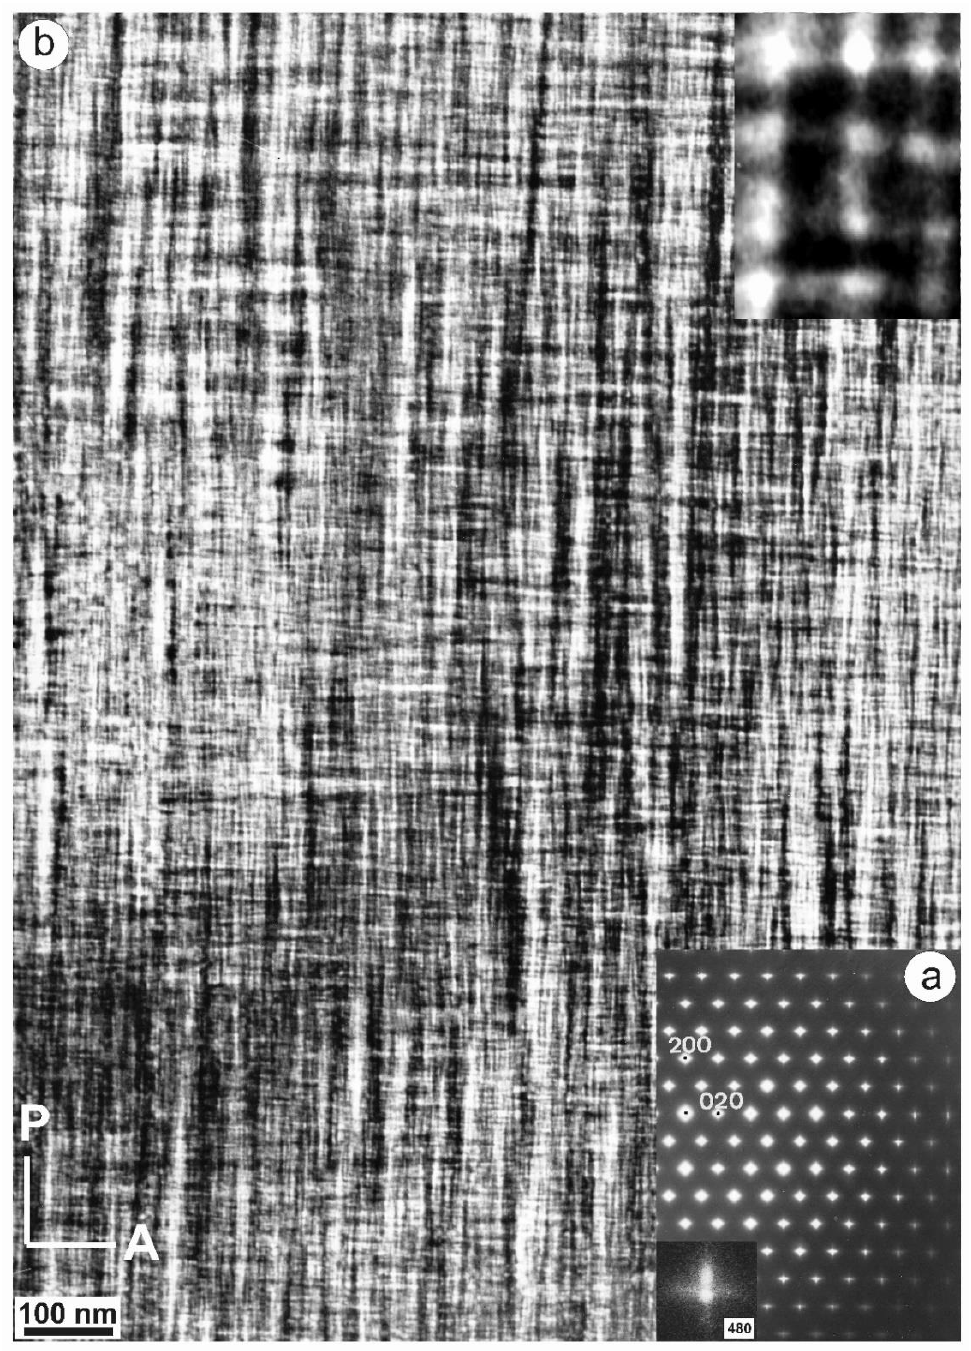
Figure 13. ( a ) An SAED pattern and ( b ) a TEM image of specimen 5963 at low resolution along the [001] zone axis shows diffuse streaks at diffraction spots and also spot-splitting at high values of (hkl), as for instance with (480). The inset in ( b ) is a high-magnification image of the low-resolution tweed pattern; it shows crossovers as bright dots at the point of intersection between units. The electron-diffraction patterns and the electron-microscopy images were obtained in a JEOL 4000EX instrument at 400 kV [77]. Reprinted with permission from Ref. [79]. 2012, The Canadian